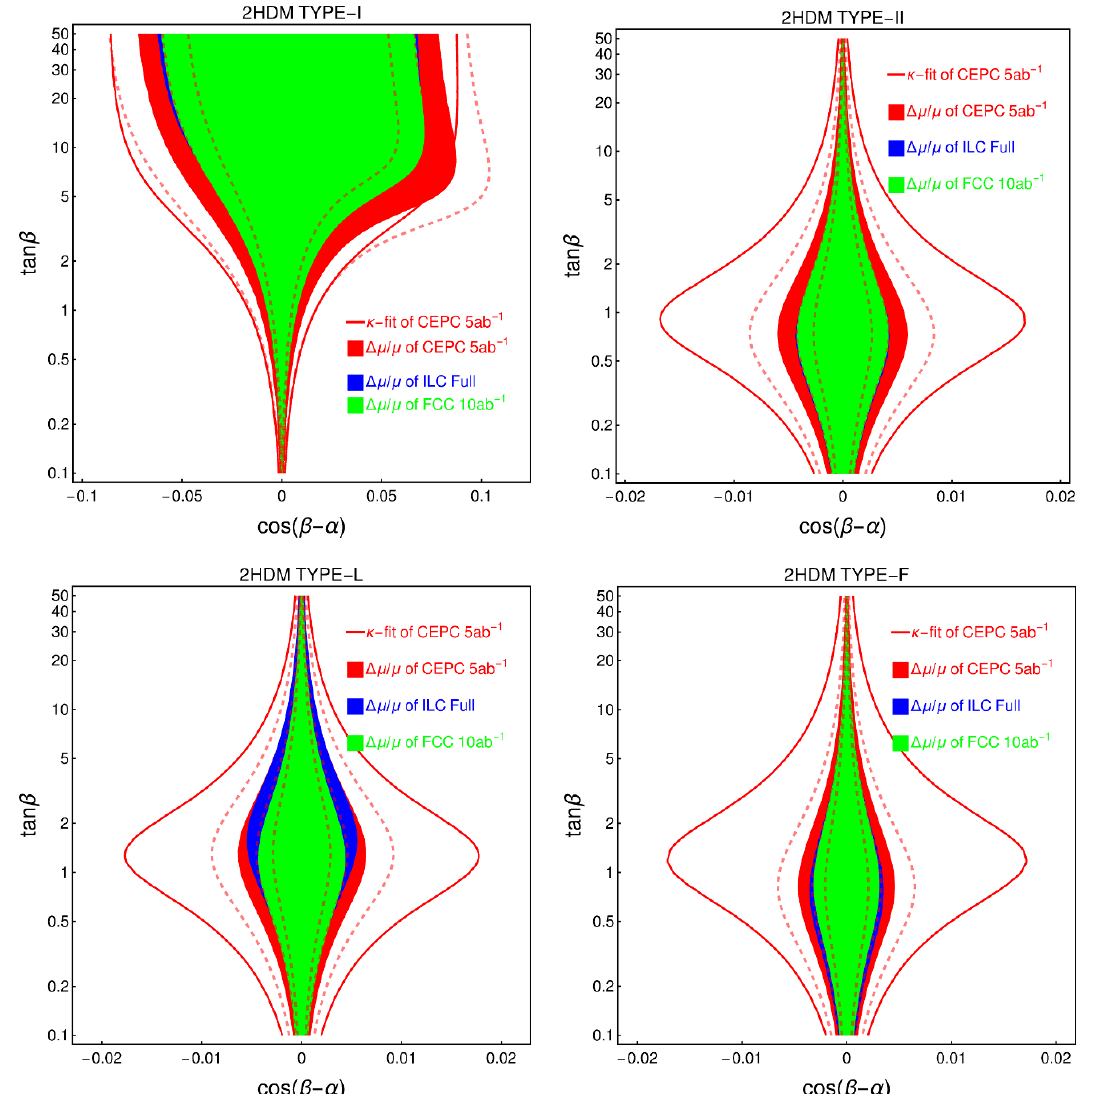
Figure 3 . The comparison between the CEPC (red region), ILC (blue region) and FCC-ee (green region) reach in the plane cos( (cid:12) (cid:0) (cid:11) ) vs. tan (cid:12) . A tiny arm region for Type-L is omitted for clarity. We also show the global (cid:12)tting results to e(cid:11)ective couplings from the 7 parameter (cid:12)t of CEPC, instead of (cid:12)tting to (cid:1) (cid:22)=(cid:22) , in red solid line. Scaled CEPC results with 2.5 ab (cid:0) 1 , 10 ab (cid:0) 1 , 25 ab (cid:0) 1 are shown in dashed lines, from outer to inner